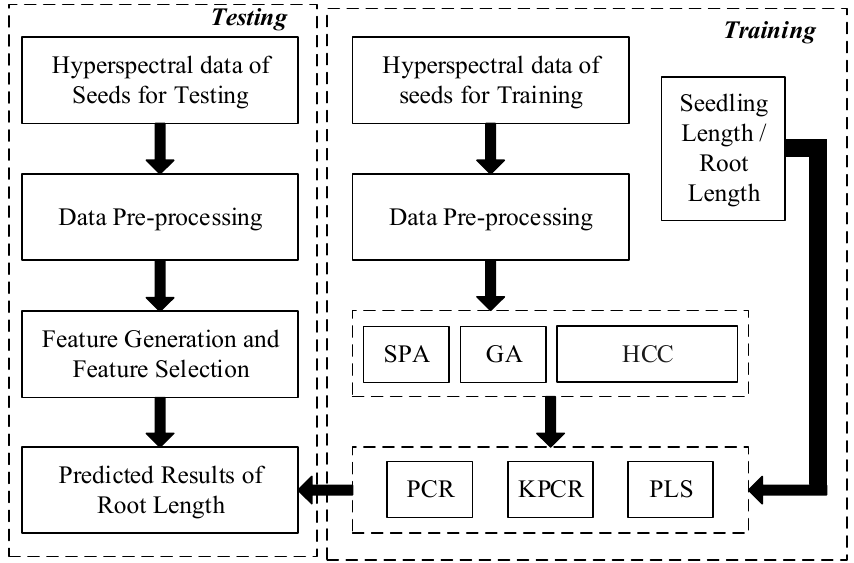
Figure 2. The detailed procedure of the training and testing model for germination prediction of sweet corn seeds. (SPA represents the successive projections algorithm. GA represents the genetic algorithm. HCC represents the highest correlation coefficient. PCR represents the principal component regression algorithm. KPCR represents the kernel principal component regression algorithm. PLS represents the partial least squares